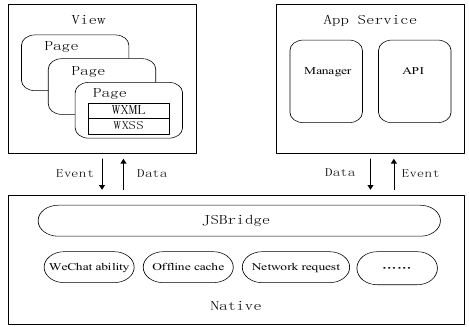
Figure1. WeChat applet structure